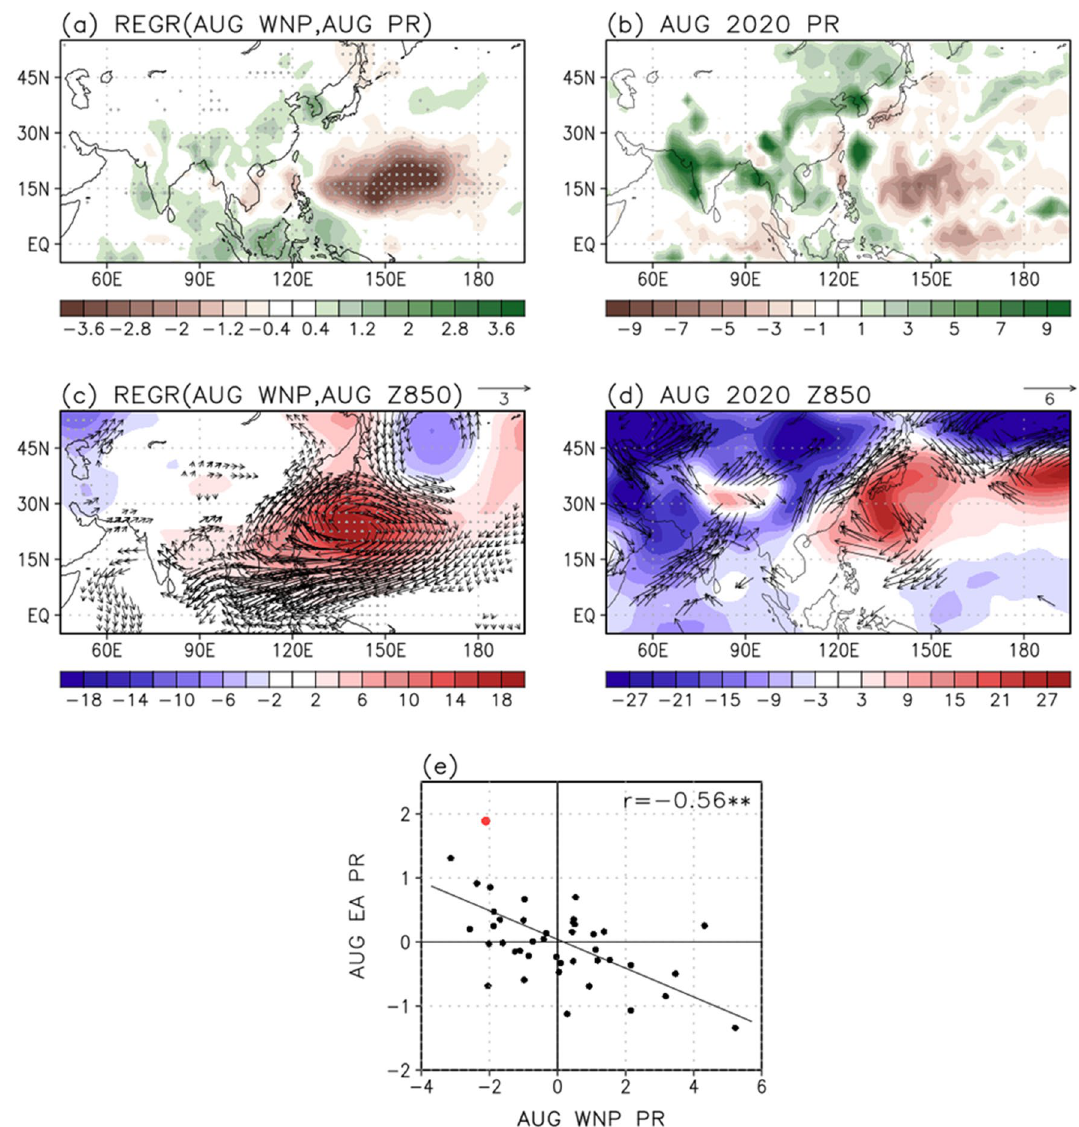
Figure 4. Regressed ( a ) rainfall (mm/day), ( c ) geopotential height (shading; m) and wind (vectors; m/s) anomalies at 850 hPa onto the subtropical WNP (140° E–180°, 10°–30° N) rainfall in August during 1979–2020. Note that the regression coefficients are multiplied by the value of subtropical WNP rainfall in August 2020. Values over the 95% confidence level based on the student t-test are stippled and represented as vectors. ( b ) Rainfall, ( d ) geopotential height and wind anomalies at 850 hPa in August 2020. ( e ) Scatter diagram between the subtropical WNP and East Asian (100°–135° E, 30°–50° N) rainfall index in August. The value for 2020 is indicated by the red dot. The symbol of ** denotes the 99% confidence level based on the student 2020, the magnitude of the subtropical WNP rainfall anomaly ranks 4th over the last 42 years. This implies that in August the subtropical WNP rainfall decrease may contribute to the development of anticyclonic anomalies, affecting the extreme East Asian rainfall. To examine atmospheric response to the subtropical diabatic forcing, the LBM 45 experiment is carried out (Fig. 5). In this experiment, the prescribed forcing is obtained from the linearly regressed local rainfall with respect to the subtropical WNP rainfall index in August (Fig. 4a), using the August basic state during 1979–2020. It is evident that the negative rainfall forcing over the subtropical WNP region (Fig. 5a) is critical in developing the anticyclonic circulation (Fig. 5b), matching well the observational pattern (Fig. 4c). Therefore, the subtropical WNP anticyclonic anomalies can be explained by the negative local rainfall anomalies through the atmospheric Rossby wave response, and then play an important role in modulating the East Asian rainfall in August. Importantly, the rainfall extremes in July and August 2020 showed different features in East Asia, as a zonally- elongated rainband located near 30° N in July (Fig. 1a), and a relatively broad one confined further north of 30° N in August (Fig. 1c). At the same time, the dominant negative rainfall anomalies over the WNP region are also distinct in July and August, showing that it moves further northeastward in accordance with the northward